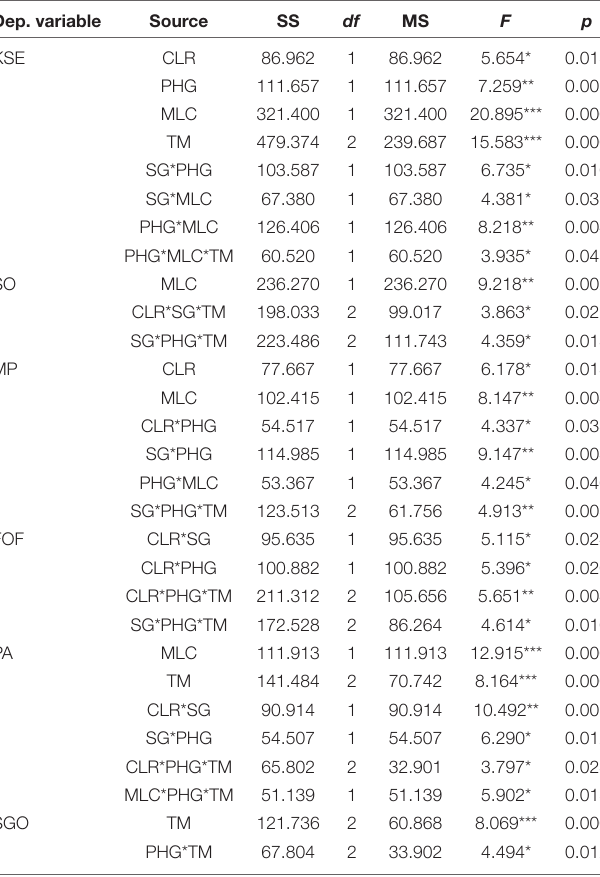
TABLE 2 | Comparison of learning motivations by dimension, temperament type, and teaching modes (analysis of variance). Dep.